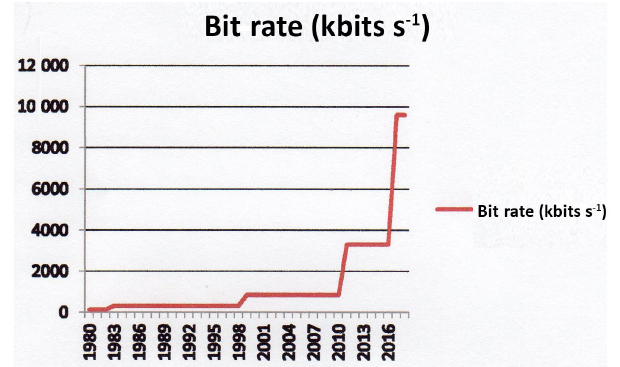
Figure 6. The development of the ARR telemetry capacity since 1980 (Courtesy of Tom Arild Blix